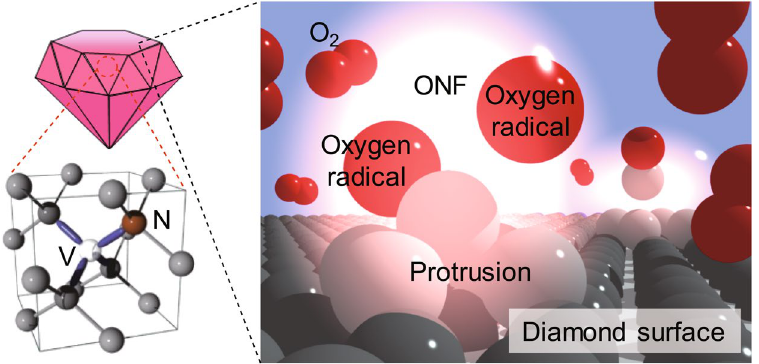
Figure 1. A schematic view of NF etching on the NV nanodiamonds. Optical near-fields (ONF) are generated by the He-Cd laser (3.81 eV) irradiation at the nanoscale protrusions on the nanodiamond surface. Since the photon energy is below the O 2 dissociation energy (5.12 eV), O 2 is only dissociated at the protrusions, thus allowing selective